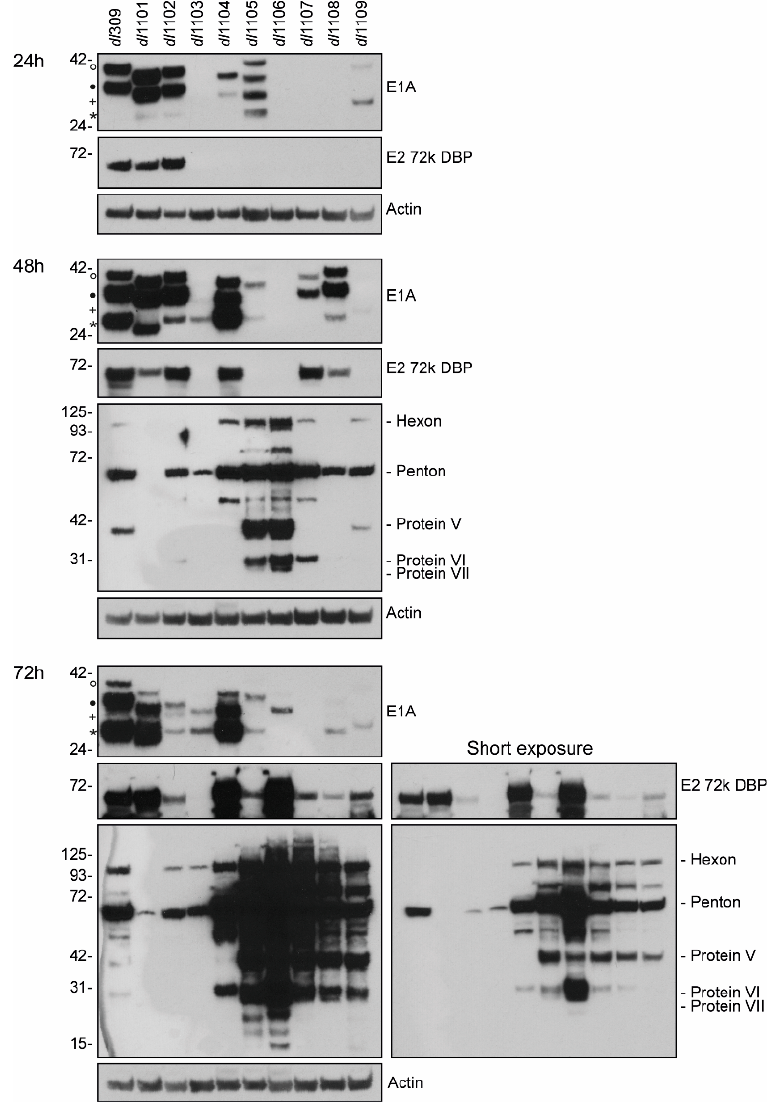
Figure 6. Viral protein expression in WI-38 cells infected with HAdV5 E1A mutants within exon 1. WI-38 cells were grown until confluence at which point medium was replaced and cells were incubated for 72 h before infection with the indicated viruses at a MOI of 100. At the specified time-points cells were harvested and proteins extracted using NP-40 lysis bu ff er as described in materials and methods. Twenty-five micrograms of total cell lysate was resolved per virus on SDS-PAGE using the Novex BOLT 4–12% gradient gels using the MES bu ff er. Proteins were subsequently transferred to a PVDF membrane using Genscript’s eBlot L1 with default settings, and the membranes were blotted for the indicated proteins. Detection was performed using secondary HRP-conjugated antibodies and exposure to radiographic film. ◦ denotes 13S-derived 289R, • denotes 12S-dervied 243R, + denotes 11S-derived 217R, and * denotes 10S-derived 171R.